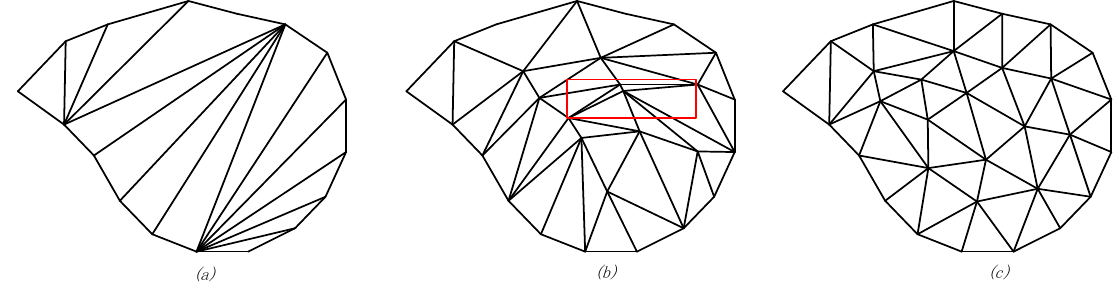
Figure 7. Hole-repairing results using different methods. (a) Filling a hole without inserting any vertices, (b) filling a hole using the one-time method with implicit surface fitting, and (c) filling holes by the proposed layer-to-layer method.